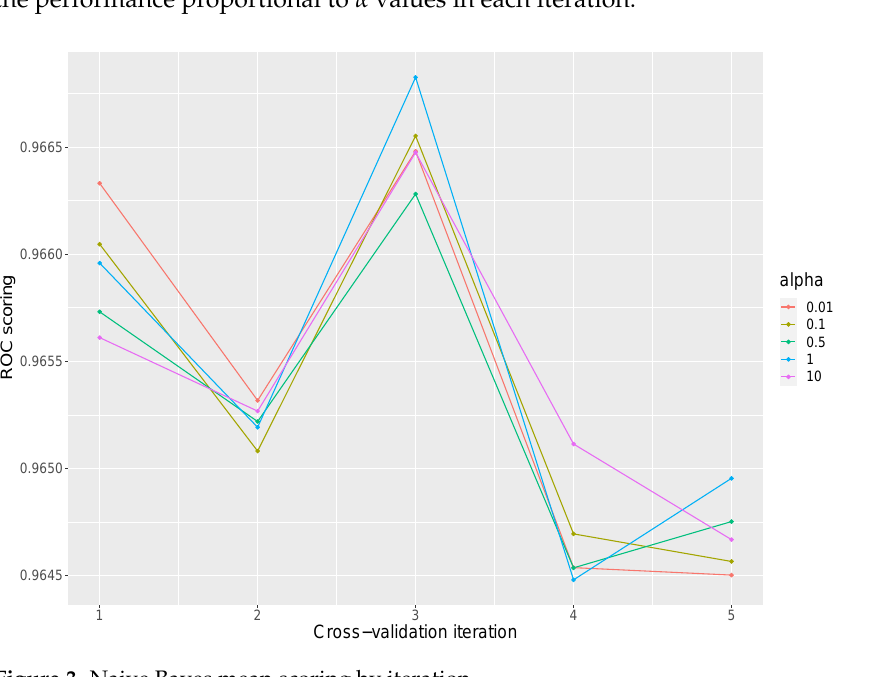
Figure 3. Naive Bayes mean scoring by